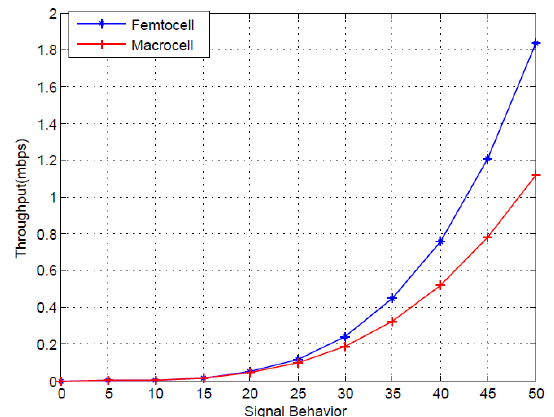
Fig 6: Signal behavior of femtocell over macrocells in an indoor